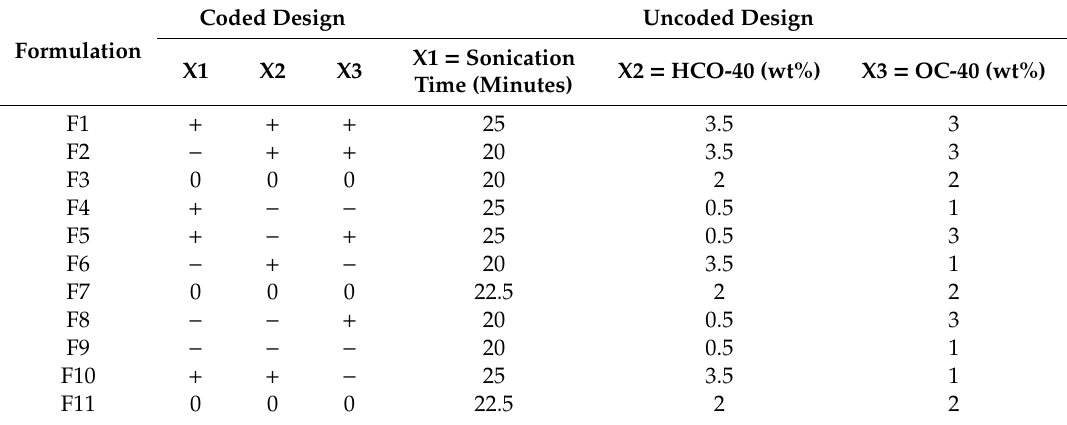
Table 1. Full factorial design of experiment by JMP software. Analysis of independent variables